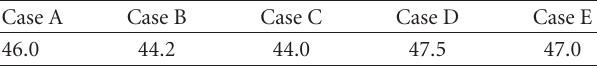
Table 2: Overall sound pressure level of the tested CFF